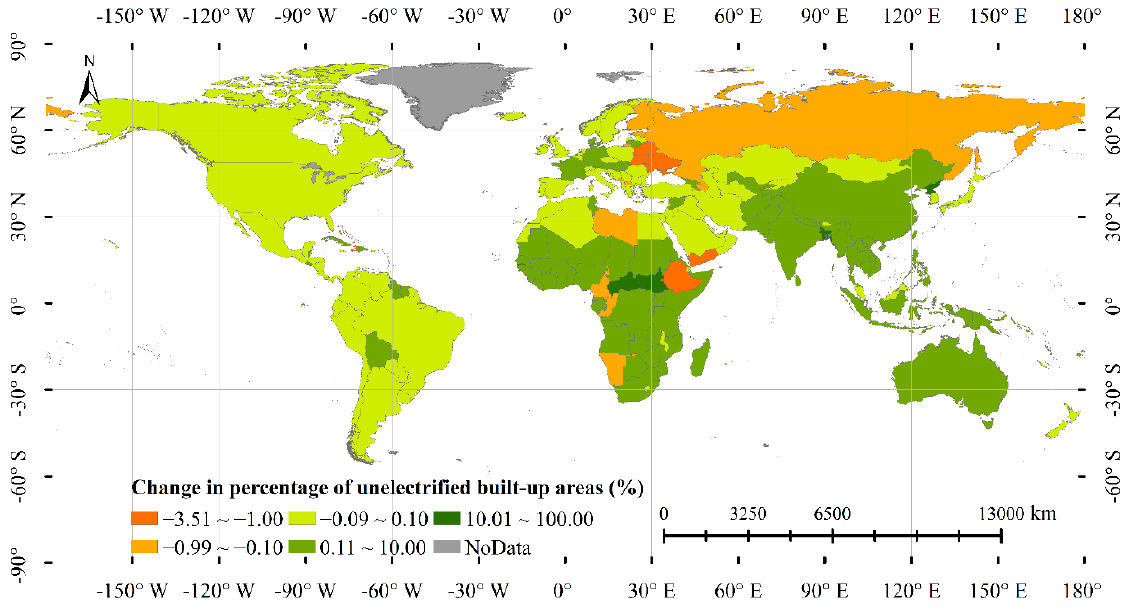
Figure 7. Changes in the percentage of the unelectrified built-up area between 2014 and